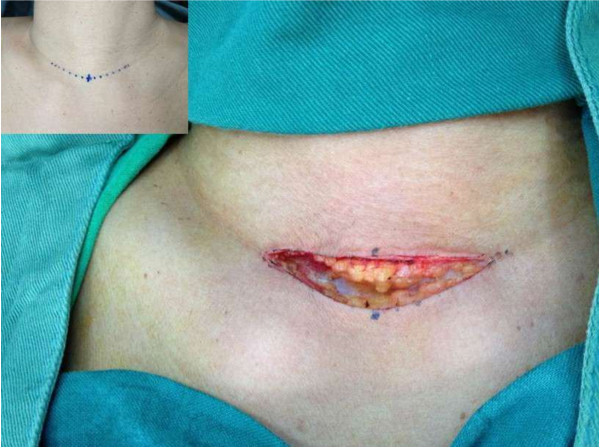
A 4 to 6 cm low collar incision.